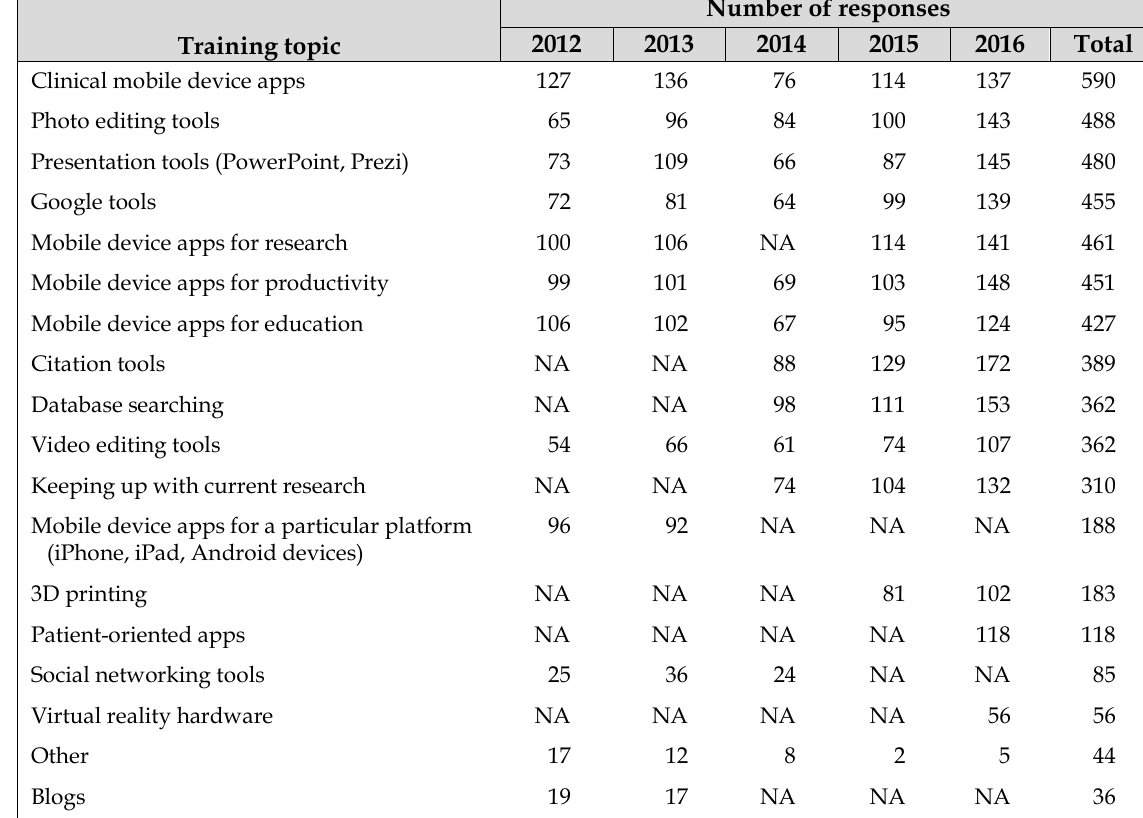
Table 1 Interest in topics for